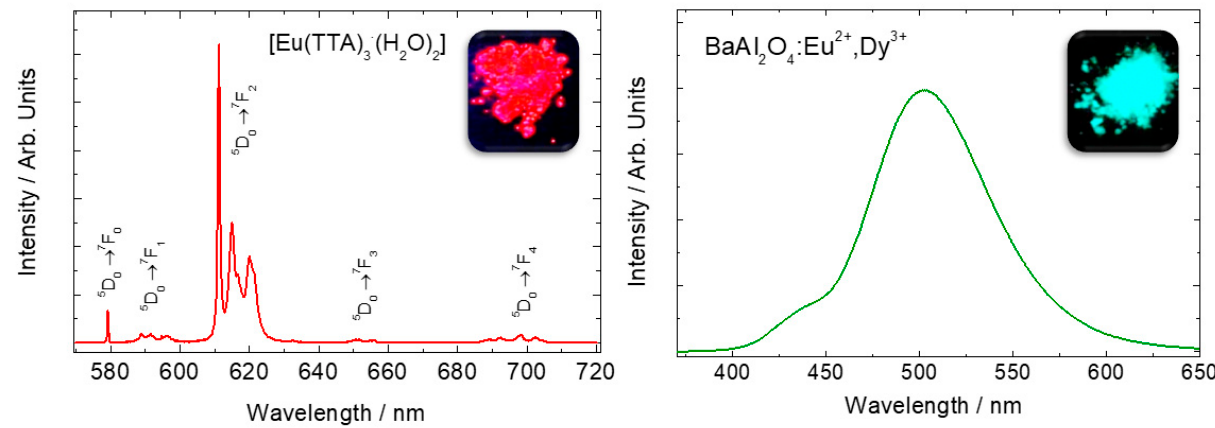
Figure 1. Emission spectra of Eu 3+ in Eu(TTA) 3 · (H 2 O) 2 complex ( left ), and Eu 2+ -doped BaAl 2 O 4 host ( right ). Eu 3+ sharp lines spectra is attributed to f-f transitions whereas the Eu 2+ broad emission band is attributed to f-d transitions. Adapted from references [3,4]. Copyright © 1997 Published by Elsevier B.V.